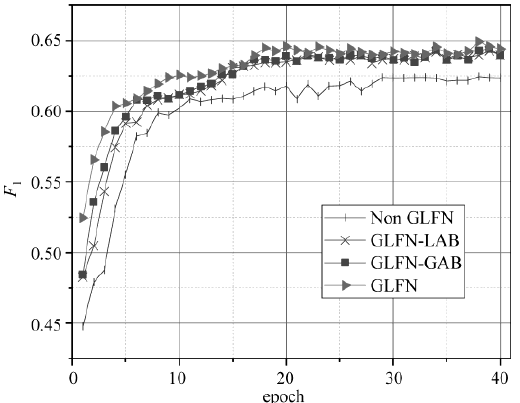
Figure 4. Training procedure for four methods on the KBP37 dataset.